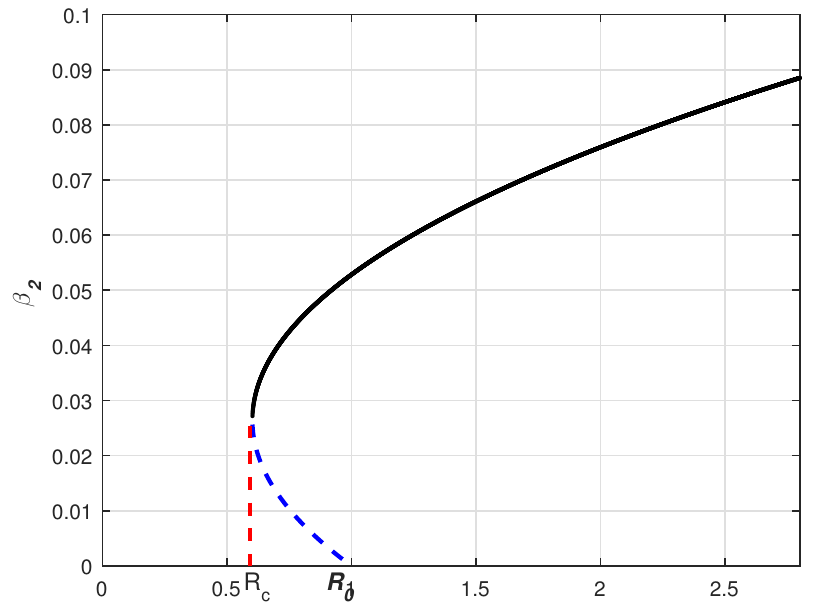
Figure 1. Backward bifurcation plot for model